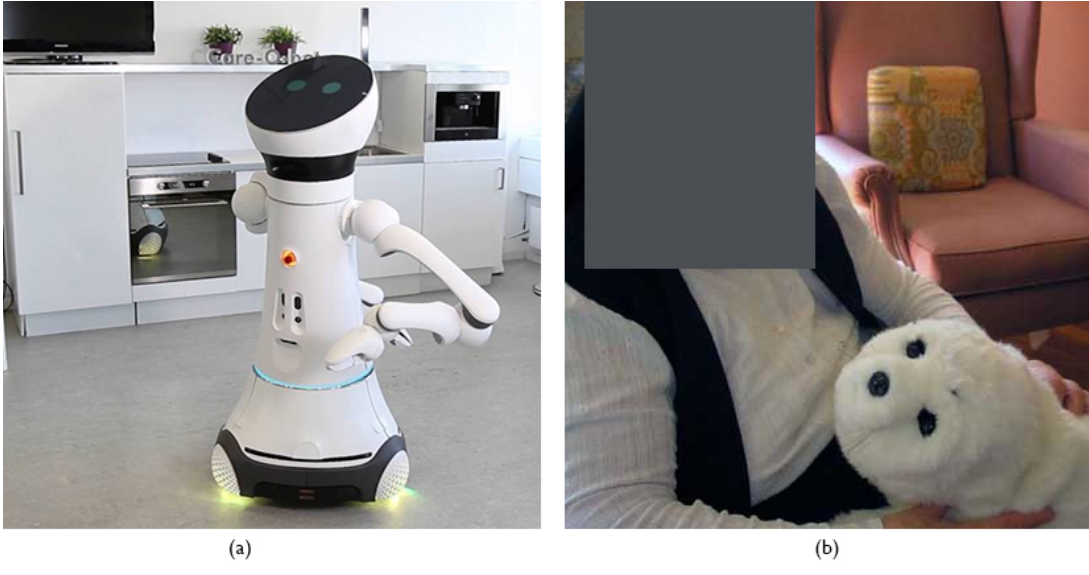
Figure 1. Examples of socially assistive robots: ( a ) Care-O-Bot robot; and ( b ) Paro